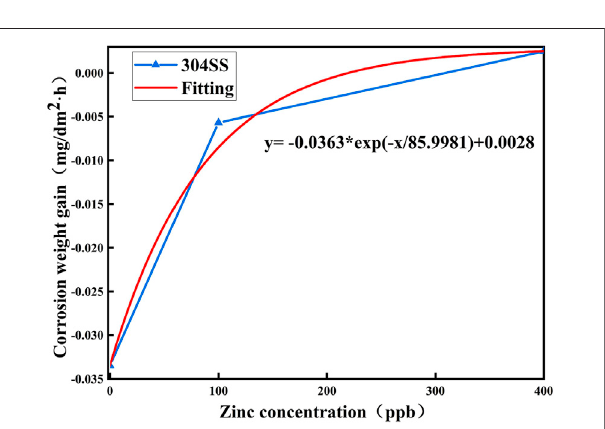
FIGURE 2 | Corrosion rate of 304SS under different zinc solutions.